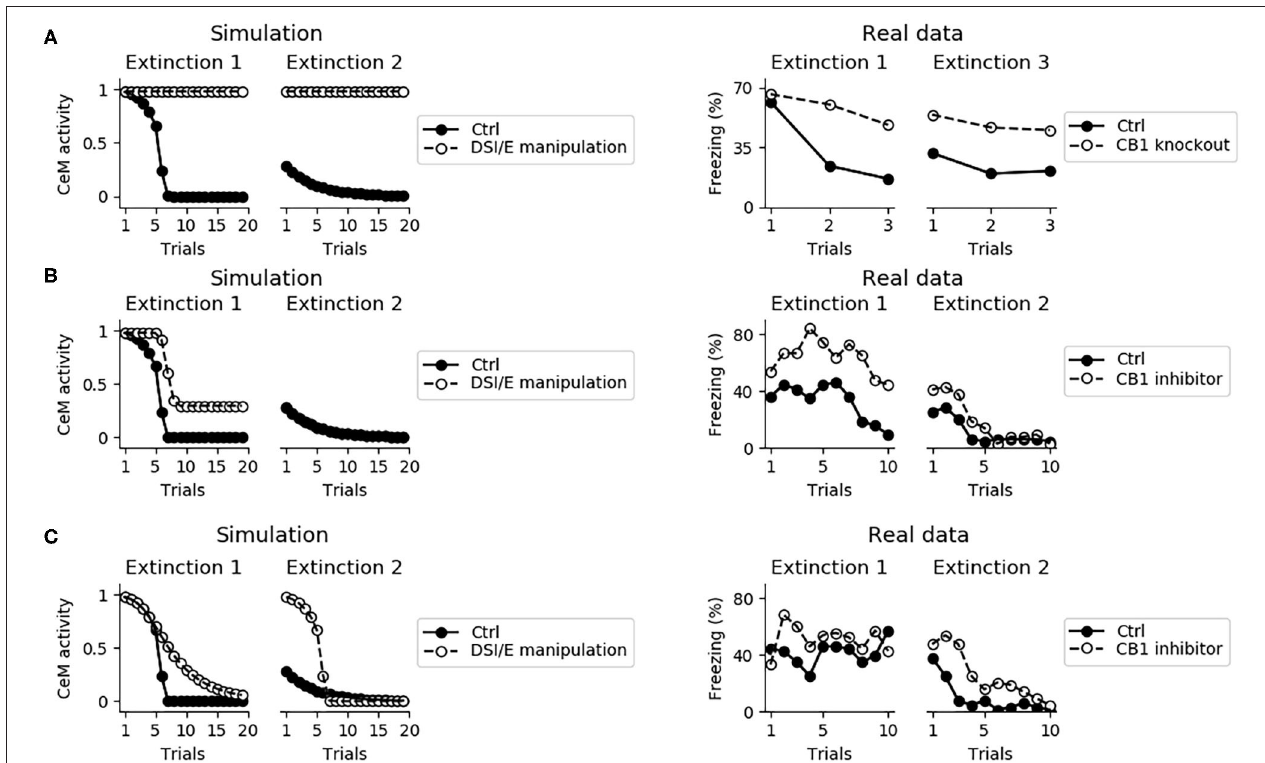
FIGURE 10 | Effects on extinction of the manipulation of the DSI/E. (A) CeM activity during the two sessions of extinction in the control model (black dots) and in a model where DSI/E is inactivated (white dots) in the whole amygdala. As shown in real data from Marsicano et al. (2002) in the right graph, knockout mice for the endocannabinoid receptor CB1 are severely impaired in both within- and between-session extinction. (B) CeM activity during the two sessions of extinction in the control model and in a model where DSI/E is inactivated in CeM during the first session. In agreement with data from Kamprath et al. (2011), extinction is impaired in the first session but is spared in the second session. (C) CeM activity during the two sessions of extinction in the control model and in a model where DSI/E is inactivated in BA during the first session. The control and DSI/E-inactivated models have comparable levels of extinction in the first session, but the manipulated models shows a deficit in between-session extinction, in agreement with real data ( Kamprath et al., 2011).